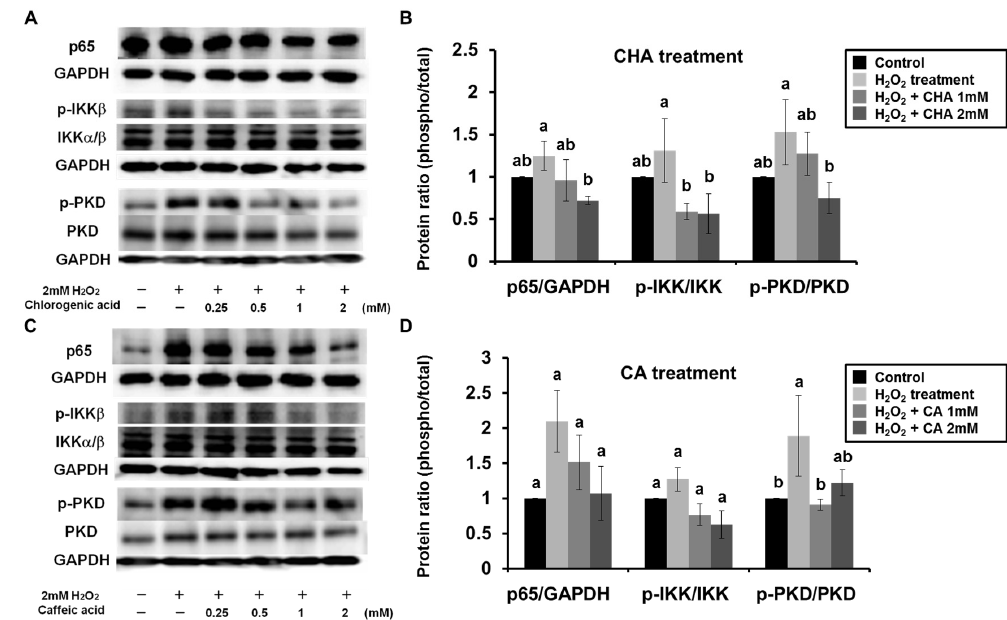
Figure 3. Chlorogenic acid (CHA) and caffeic acid (CA) suppressed activation of hydrogen peroxide (H 2 O 2 )-induced protein kinase D (PKD)-I- κ B kinase (IKK)-nuclear factor kappa-light-chain-enhancer of (H 2 O 2 ) ‐ induced protein kinase D (PKD) ‐ I ‐κ B kinase (IKK) ‐ nuclear factor kappa ‐ light ‐ chain ‐ enhancer activated B cells (NF- κ B) signaling. Caco-2 cells were pre-incubated for 3 h with 0.25–2 mM CHA or of activated B cells (NF ‐κ B) signaling. Caco ‐ 2 cells were pre ‐ incubated for 3 h with 0.25–2 mM CHA